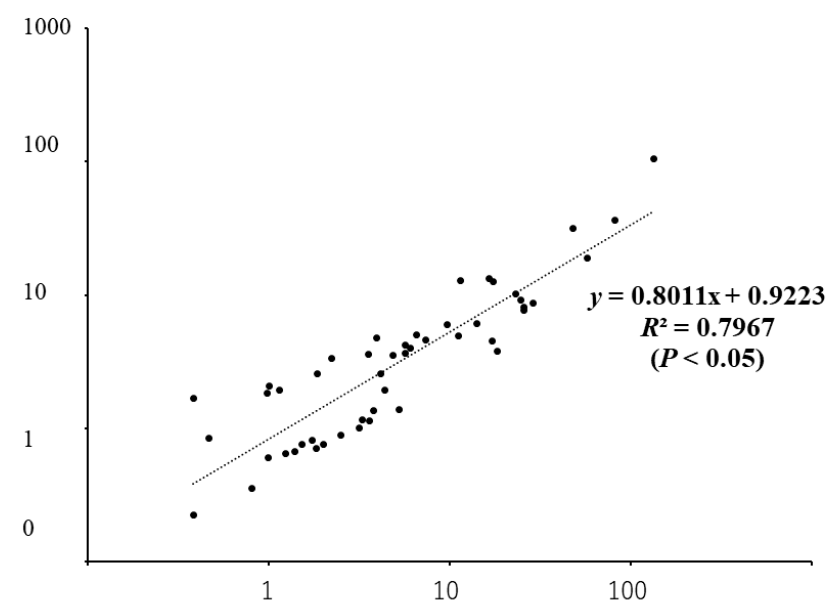
Figure 3. IL12 (p70) and VEGF levels in cerebrospinal fluid obtained from all patients.